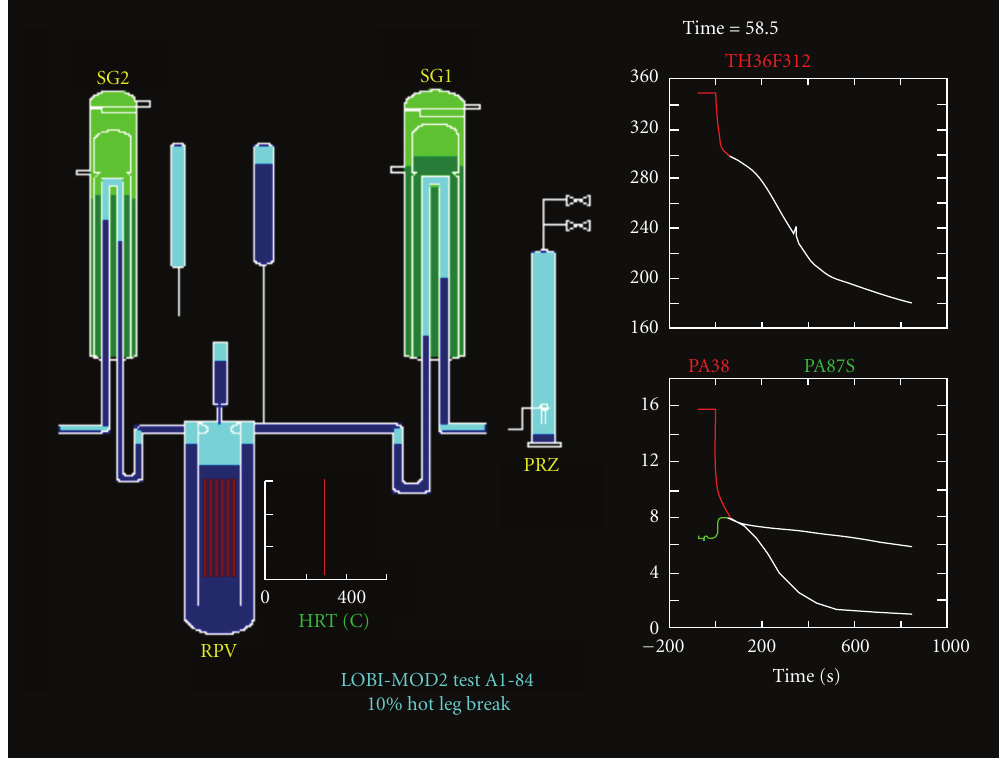
Figure 19: A1-84 experiment collapsed levels display and primary and secondary pressures (STRESA JRC database). Table 4: Resulting sequence of events, comparison between experimental test and calculated results of A1-84. Events/set